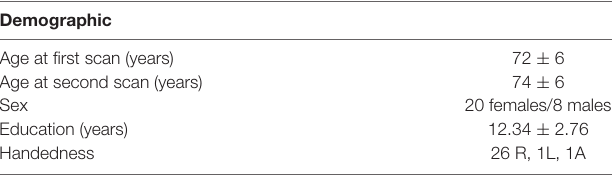
TABLE 1 | Participant demographic information.